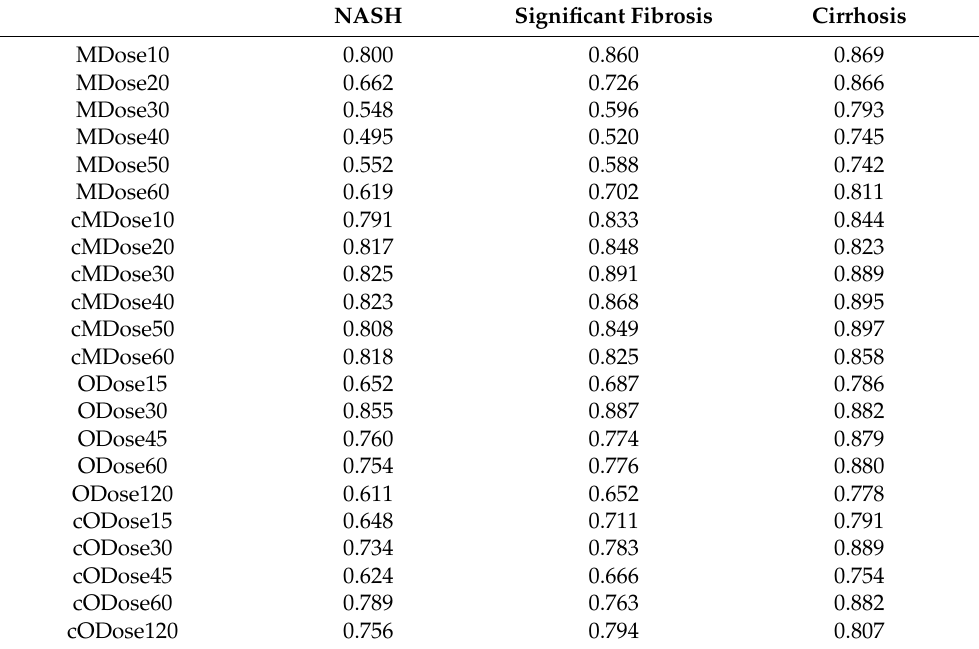
Table 4. AUROC for different parameters.